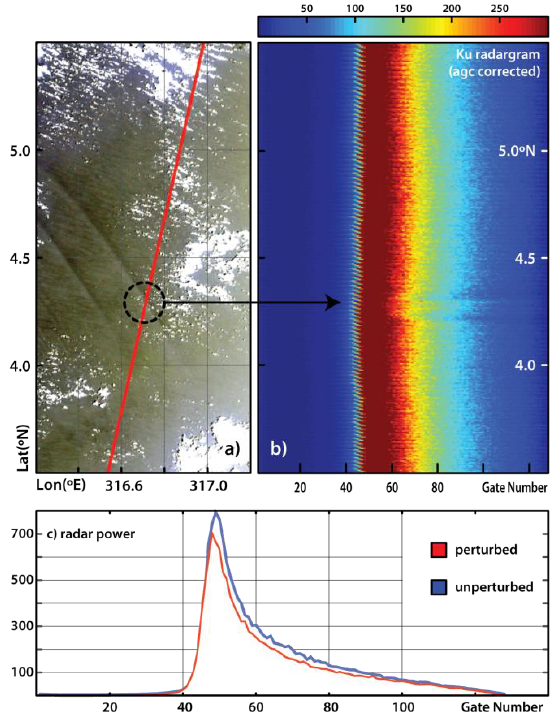
Figure 3. ( a ) Sentinel-3A OLCI image (Level 1b) dated 2017.10.11 acquired at 12:54:29 UTC (start time) presented in quasi-true color. The red line represents the Sentinel-3A track on the ground. ( b ) Radargram of SRAL composed of a sequence of 20 Hz waveforms. Backscatter power is represented in color with arbitrary units displayed in the color bar. ( c ) Averaged waveforms for perturbed (red) and unperturbed (blue) sea surface